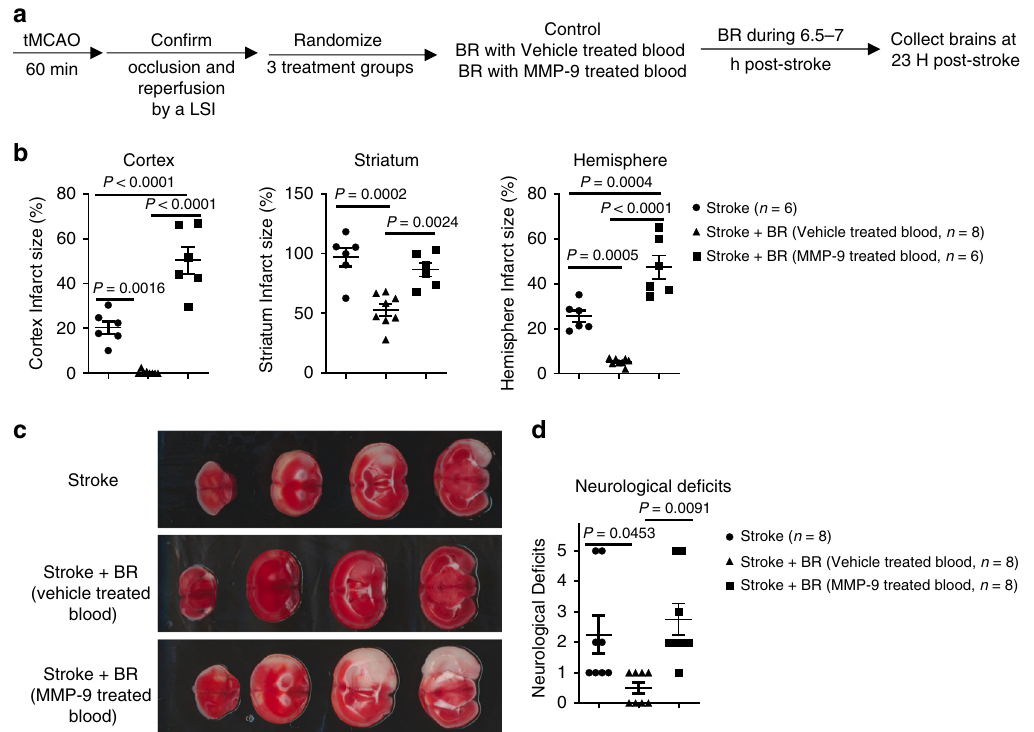
Fig. 8 MMP-9 diminished the therapeutic effects of the blood replacement in stroke mice. a Experimental design. Mice (8-month-old males) underwent tMCAO for 60 min. The occlusion and reperfusion were con fi rmed by a laser speckle imager (LSI). Mice were randomized into three groups: the fi rst group is the stroke group received tMCAO, the second group is the blood replacement (BR) group receiving 250 µ l of blood with vehicle and blood withdrawal, and the third group is the BR group receiving 250 µ l of blood treated with activated MMP-9 (5 µ g ml − 1 ) and blood withdrawal. b Quanti fi cation of infarct volumes in the cortex, striatum, and total hemisphere. MMP-9-treated blood did not signi fi cantly reduce the infarct volume. Stroke group (circles, n = 6), stroke with vehicle-treated BR group (triangles, n = 8), and stroke with MMP-9-treated BR group (squares, n = 6). c Representative TTC-stained coronal brain sections used for infarction analyses. d Neurological de fi cits were not signi fi cantly improved in the BR group with MMP-9-treated blood. Stroke group (circles, n = 8), stroke with vehicle-treated BR group (triangles, n = 8), and stroke with MMP-9-treated BR group (squares, n = 8). Data were presented as means ± SEM. One-way ANOVA followed by post hoc Tukey ’ s multiple comparison tests. Source data are provided as a Source Data fi